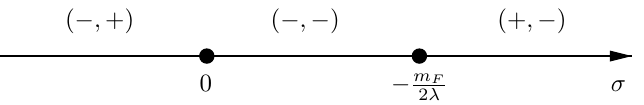
Figure 9. Regions of validity for di(cid:11)erent branches of the potential for sgn( m F )sgn( (cid:21) ) = (cid:0)